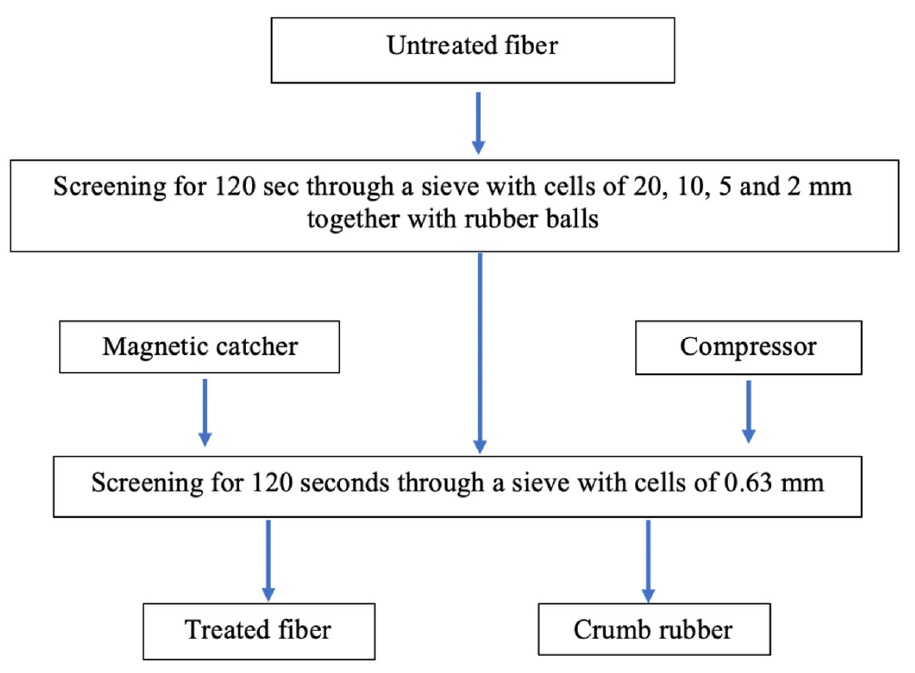
Table 2. Chemical composition of the clinker.